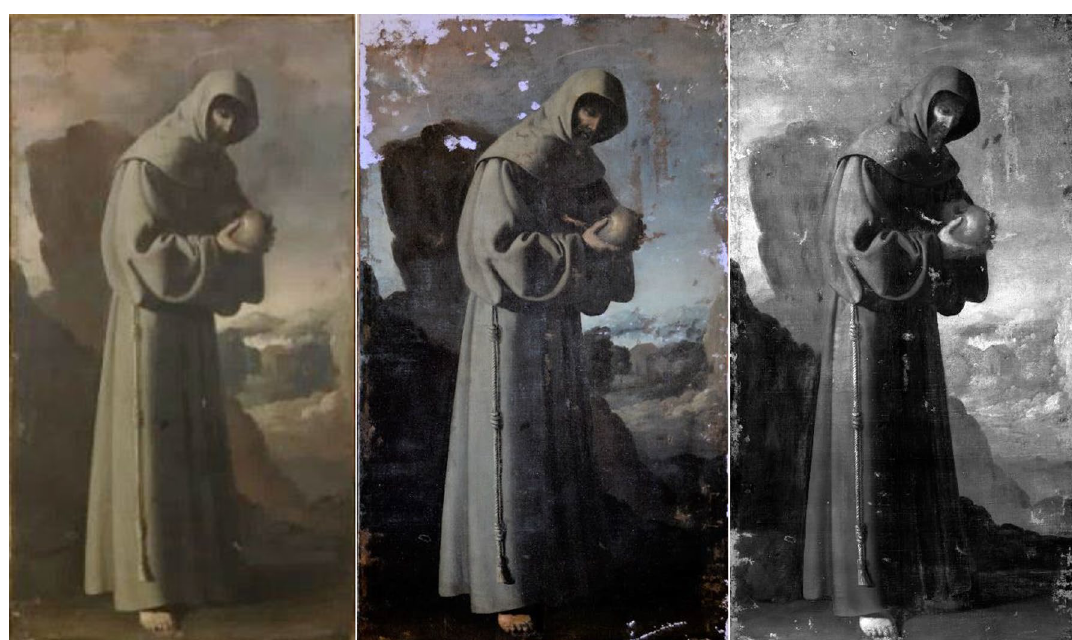
Figure 2. Painting of Saint Francis of Assisi ( SF ) in visible (left), UV (centre), and IR